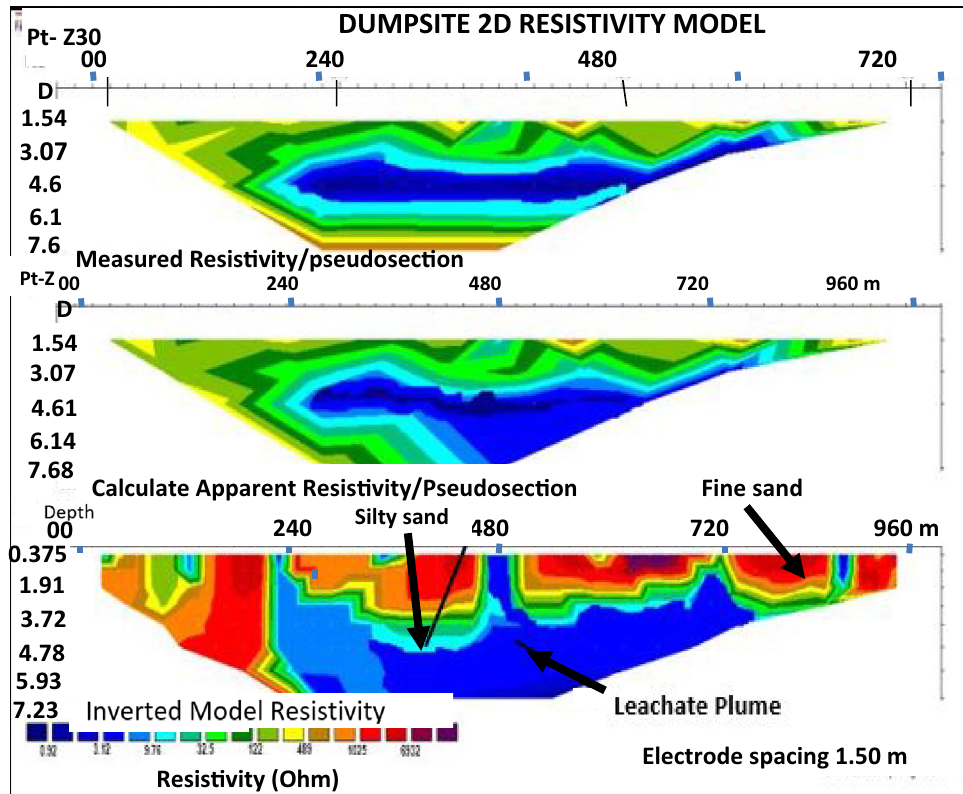
Figure 7. 2D inversion of the Wenner-array data along Profile 3 showing variation in resistivity in the subsurface, with blue colour representing least resistivity and red colour shoing highest resistivity